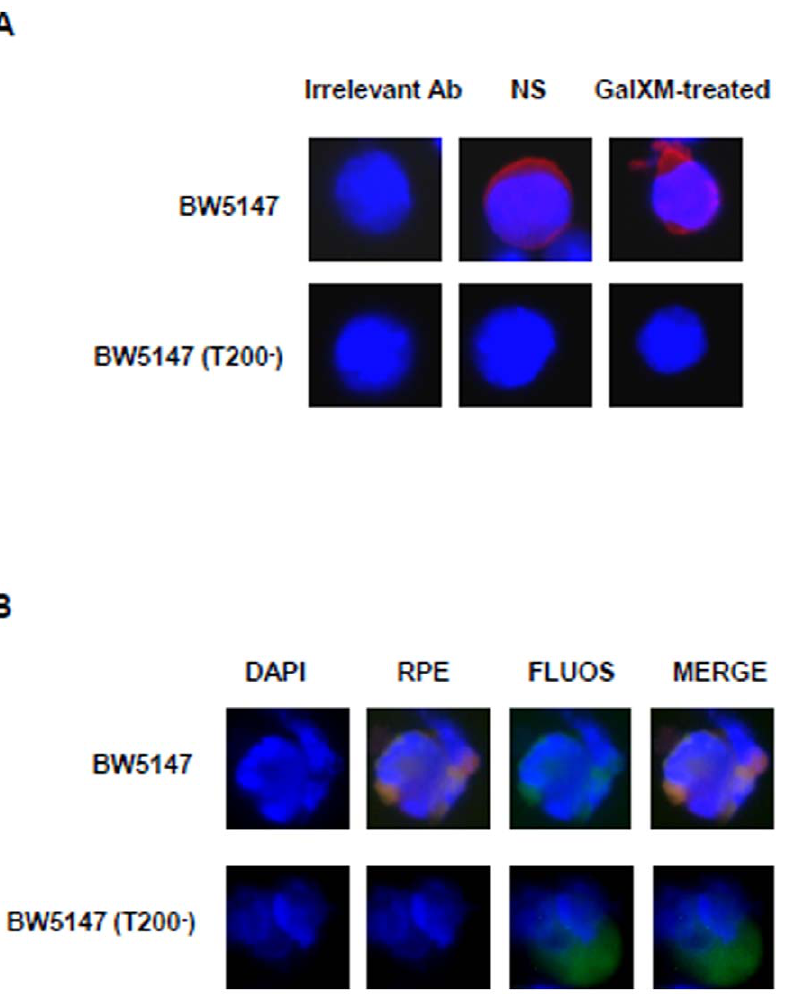
Figure 3. Segregation of CD45 GalXM-induced on BW5147 cells. Fluorescence microscopy analysis of BW5147 and BW5147 (T200 2 ) cells incubated for 2 h in the presence or absence (NS) of GalXM ( A ) or GalXM-FLUOS (green) ( B ) (both 10 m g/ml). After incubation, cells were labelled with RPE mAb to CD45 (red) and then examined under fluorescent light microscopy in the presence of DAPI (blue). Note the CD45 segregation in BW5147 cells treated with GalXM ( A ). The colocalization of GalXM with CD45 and the receptor segregation on BW5147 cells was demonstrated in the merged image of panel B ( B ). Original magnification 100x.